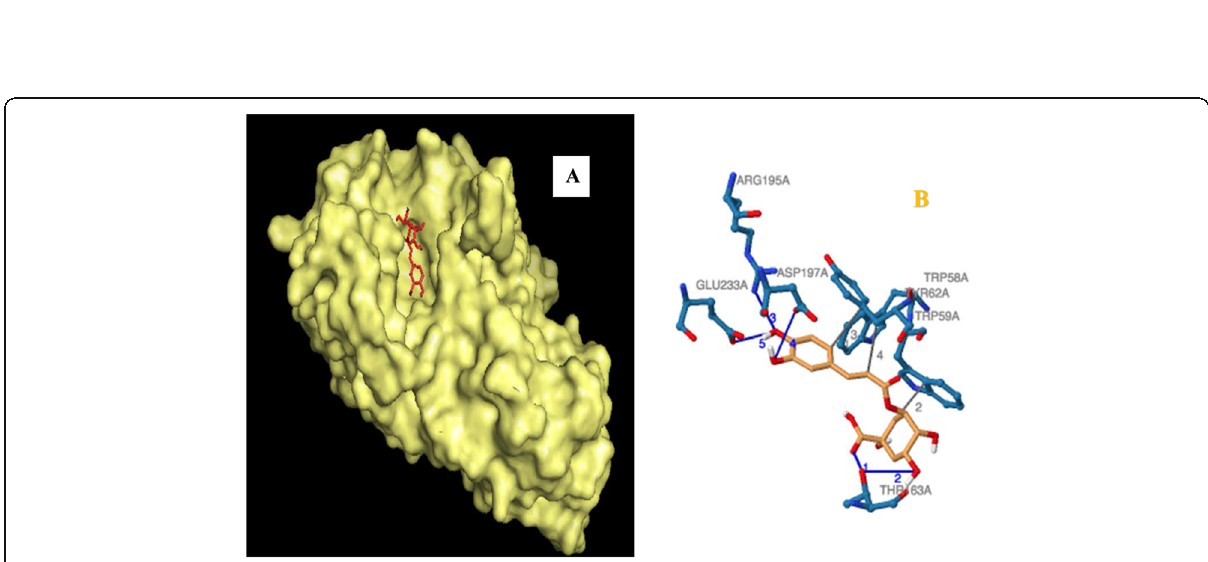
Fig. 8 Binding pose and binding site of caffeic acid with alpha amylase (panel A), molecular interaction of caffeic acid with amino acid residues within the binding pocket of the protein structure (panel B)